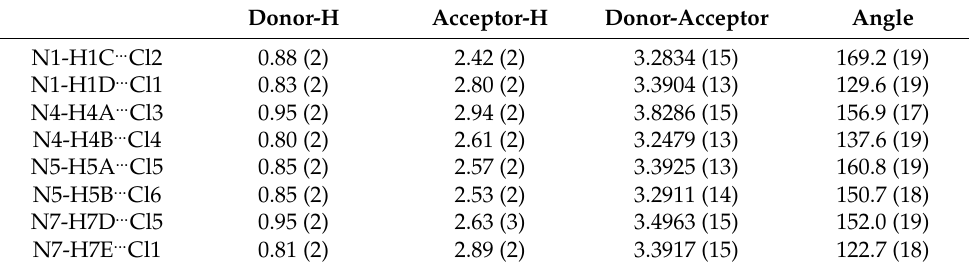
Table 2. Hydrogen bond distances (Å) and angles ( ◦ ) of Zn1 .